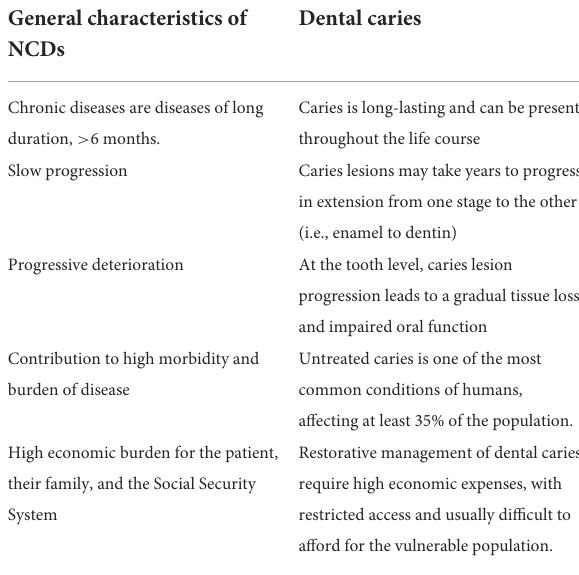
TABLE 2 Parallel comparison between general characteristics of common non-communicable diseases (NCDs) and dental caries. General characteristics